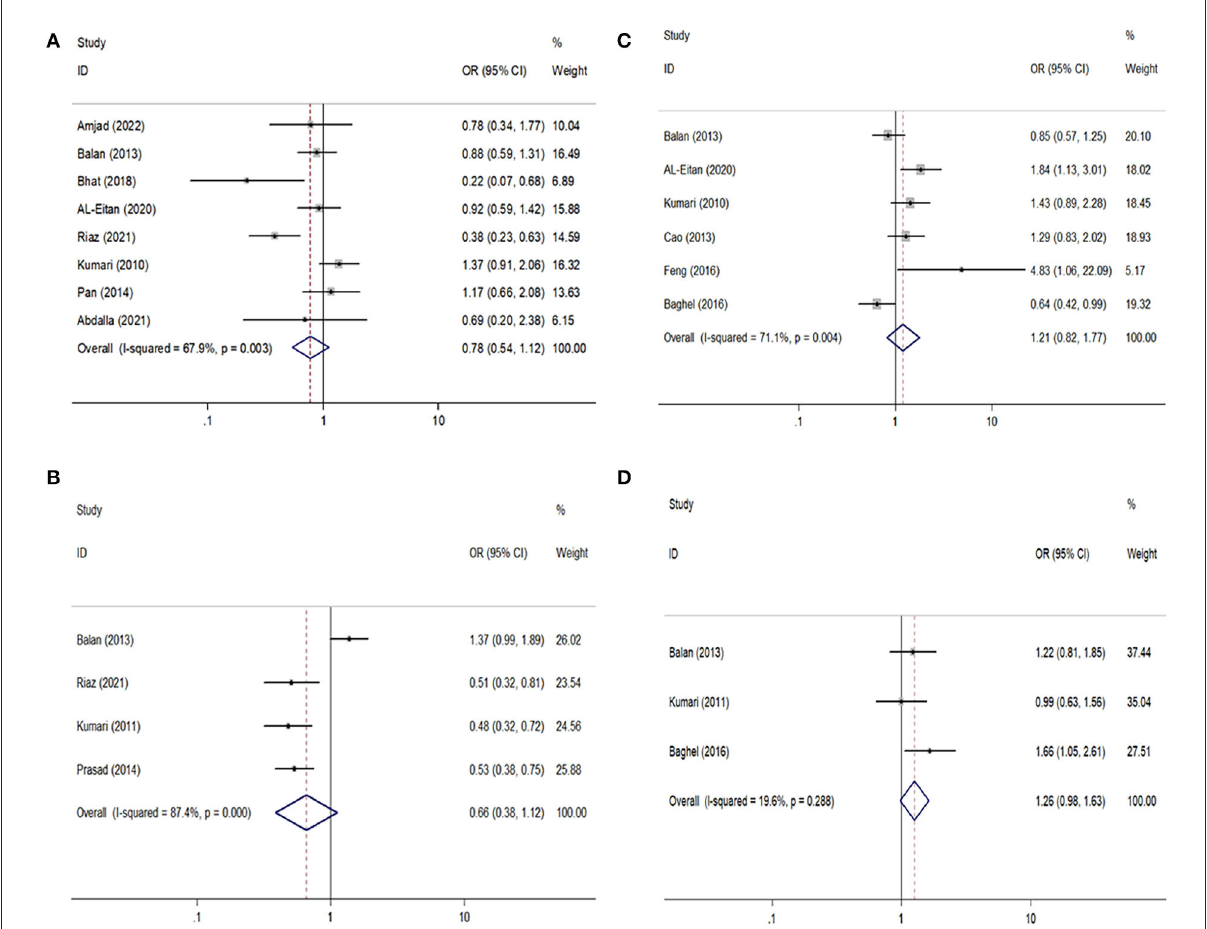
FIGURE2 Forest plots of GABRA1 rs2279020 and GABRA6 rs3219151 polymorphisms with the risk of epilepsy and drug resistance. (A,B) Comparison of rs2279020 and rs3219151 with the risk of epilepsy; (C,D) comparison of rs2279020 and rs3219151 with the risk of drug resistance.